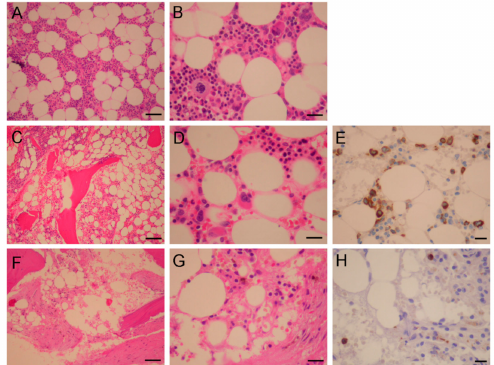
Figure 10. Severe bone marrow suppression in a myelodysplastic syndromes (MDS) case. Micrographs of bone marrow sections from normal ( A , B ) and a MDS case before ( C – E ) and after ( F – H ) azacitidine treatment, examined by Giemsa ( A – D , F , G ) and myeloperoxidase staining ( E , H ). Scale bars in ( A , C , F ), 100 µ m; scale bar in ( B , D , G , E , H ), 10 µ m.